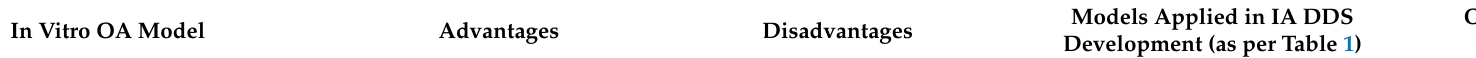
Table 2. Overview of advantages and disadvantages of in vitro OA models and their application in IA DDSs